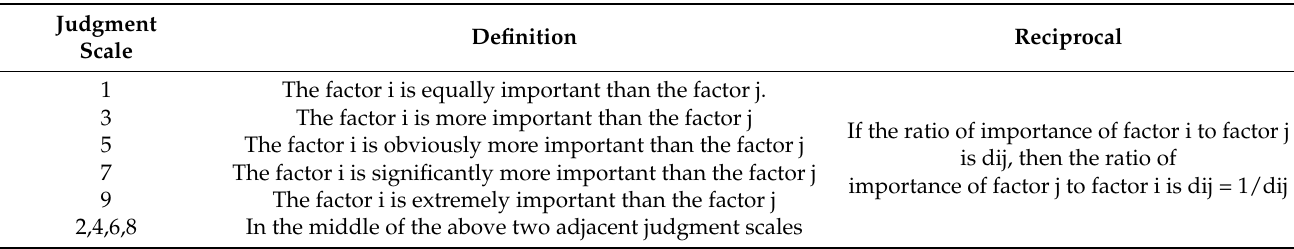
Table 2. Interpretation of 1–9 scale